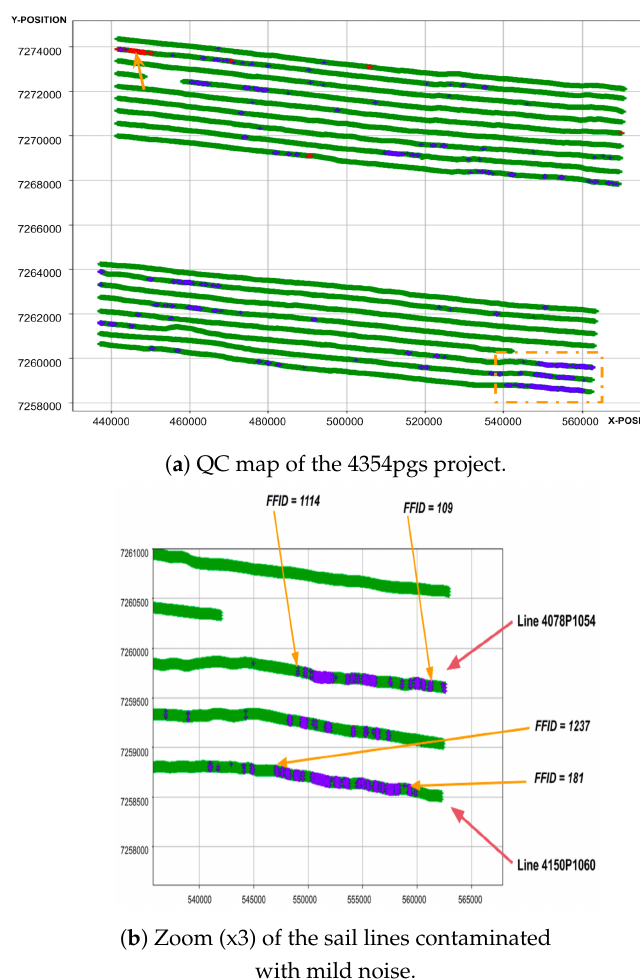
with mild noise. Figure 7. Assessment of the QC prediction of the 4354pgs project.